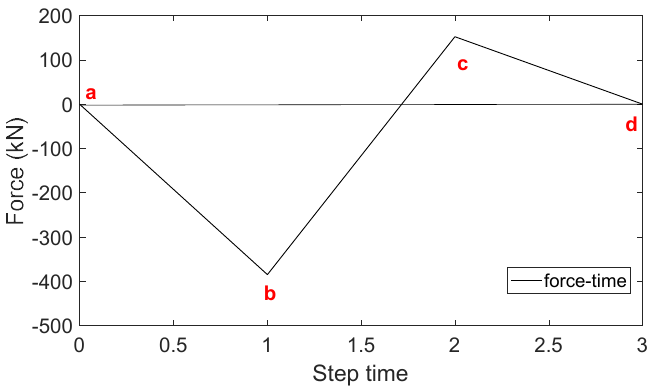
Figure 5. Loading condition in one cycle [27].